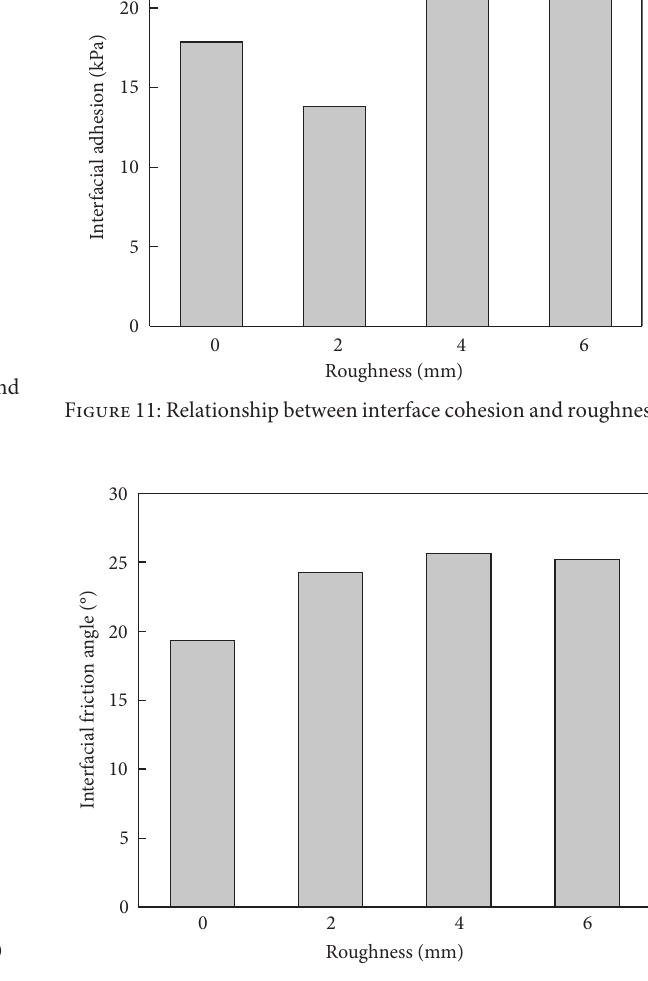
Figure 12: Relationship between interface friction angle and roughness.